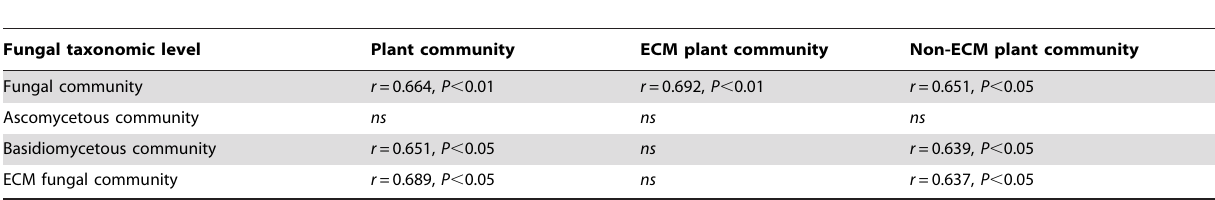
Table 4. Correspondence of fungal communities with all plant, ECM plant and non-ECM plant species communities based on Procrustes correlation analysis with Bonferroni corrected P